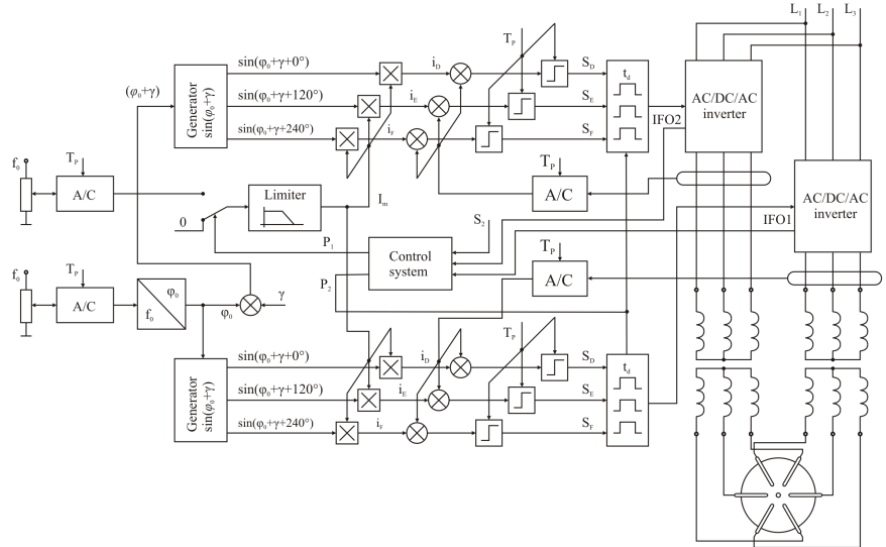
Figure 14. Scheme connection of the AC/DC/AC power supply system of the sixth electrode GAD rector for decomposition of volatile organic compounds (VOCs) emitted during industrial processes [55].